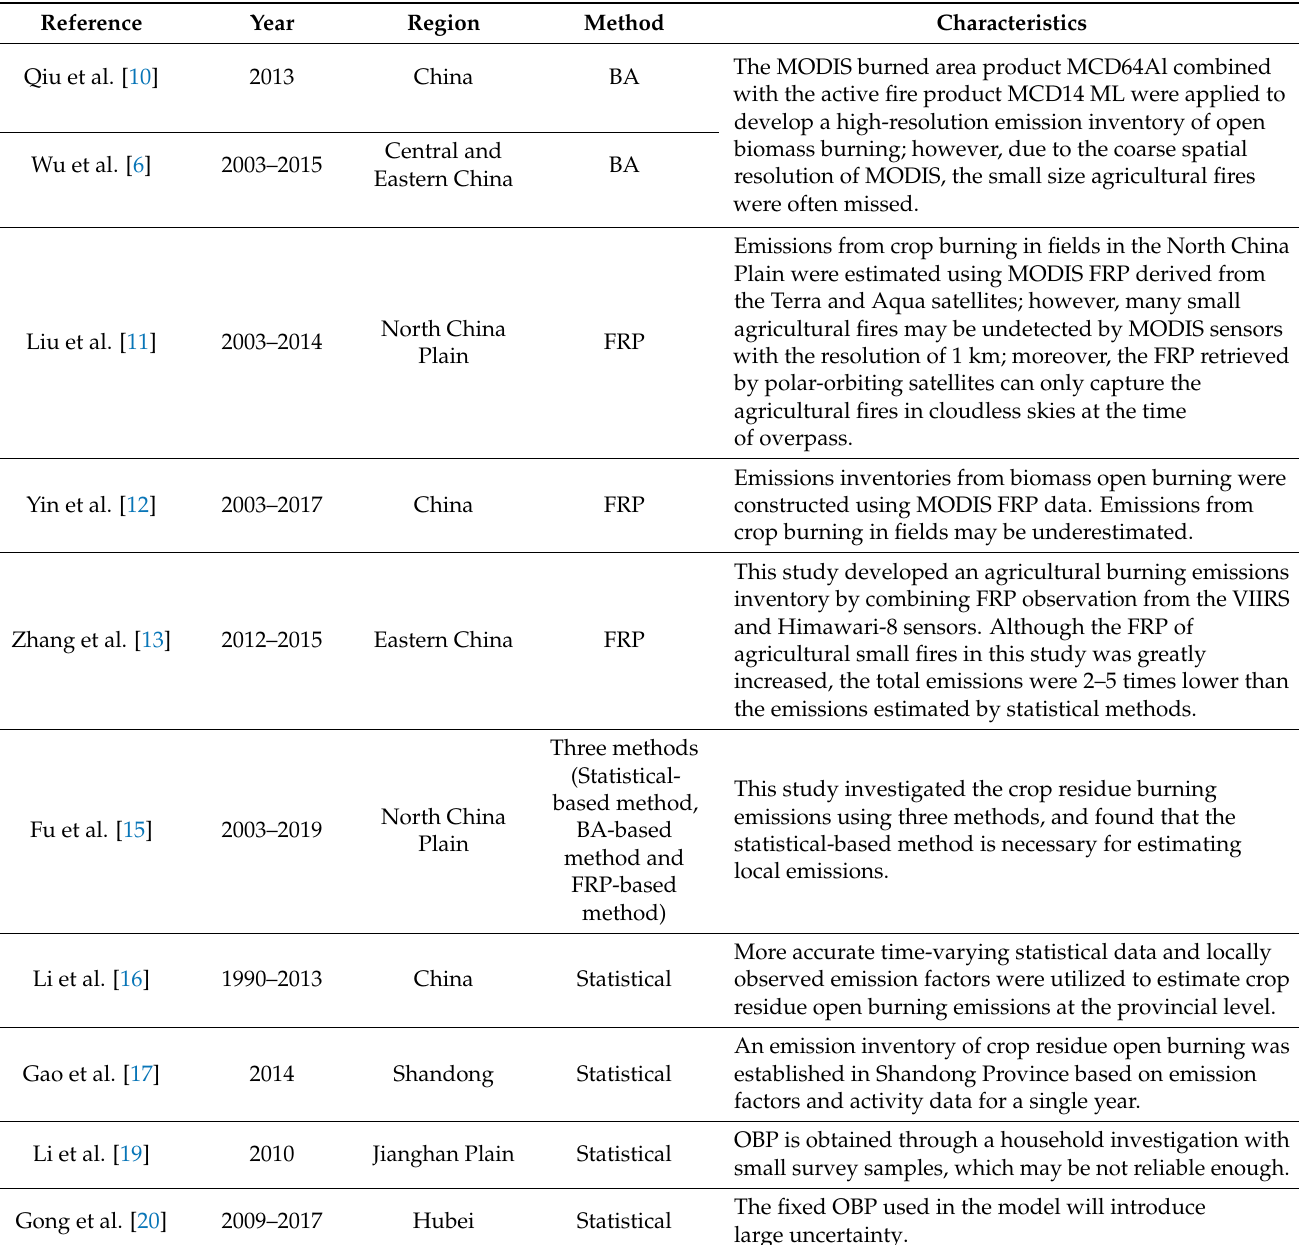
Table 1. The characteristics of previous